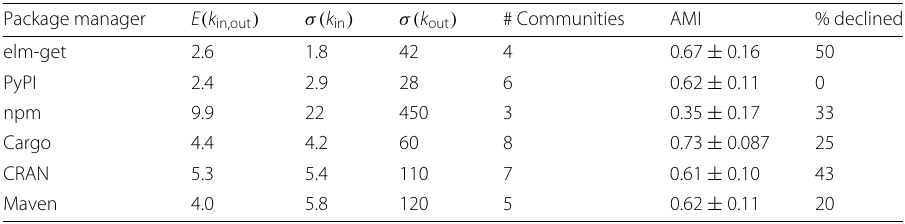
Table 1 Summary statistics for each ecosystem